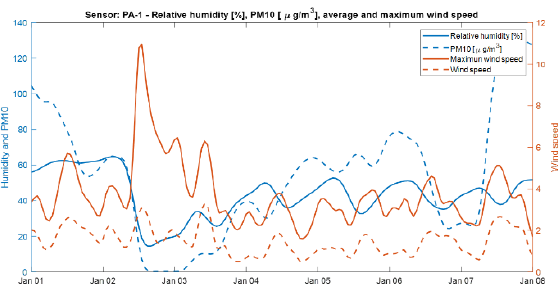
Figure 5. Joint graphic of relative humidity and PM 10 in blue, referred to the left y-axis and average and maximum wind speed, in red and referred to the right y-axis. Data are related to one sensor and the first week of the year 2019